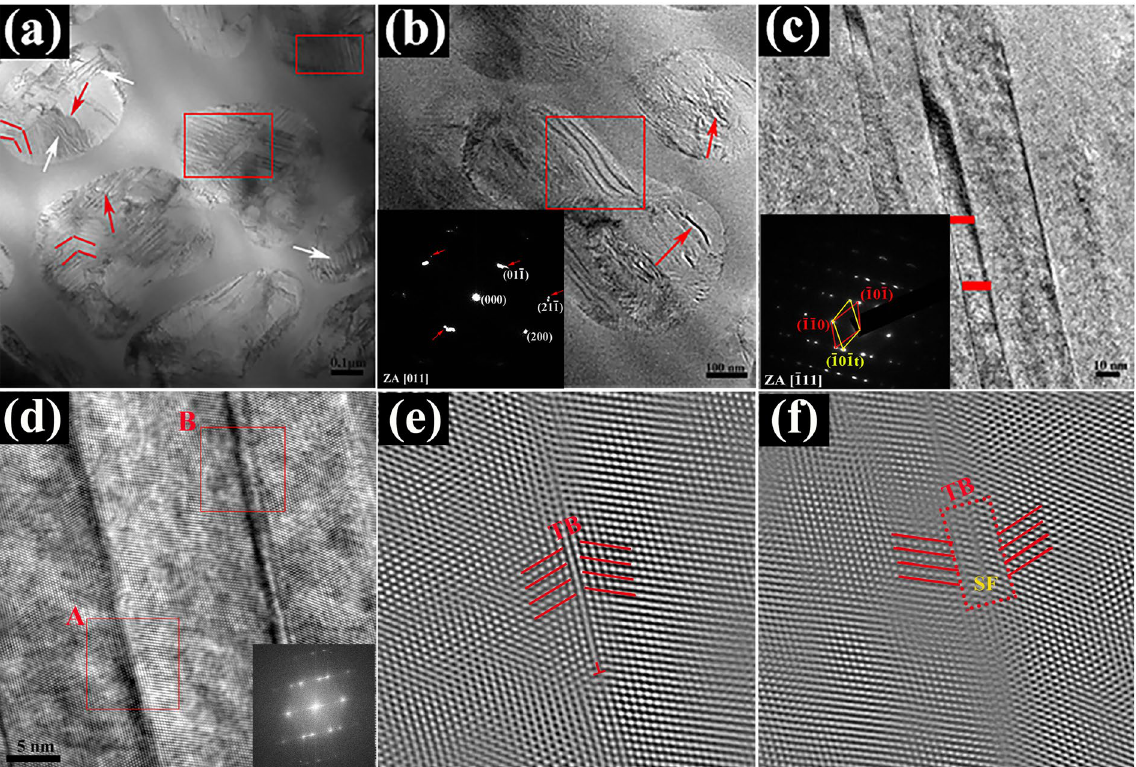
Figure 5. ( a ) BF TEM image of the present Ti-based MGMCs after deformation; ( b ) the magnified TEM image of special deformed dendrites, the inset corresponding SAED pattern; ( c ) the magnified TEM image of the twin structures in dendrites and the insert image corresponding SAED pattern; ( d ) The HRTEM image of the twin structures and the FFT pattern shown in inset; ( e ) and ( f ) are IFFT images of the part of rectangle region A and B in ( d ),